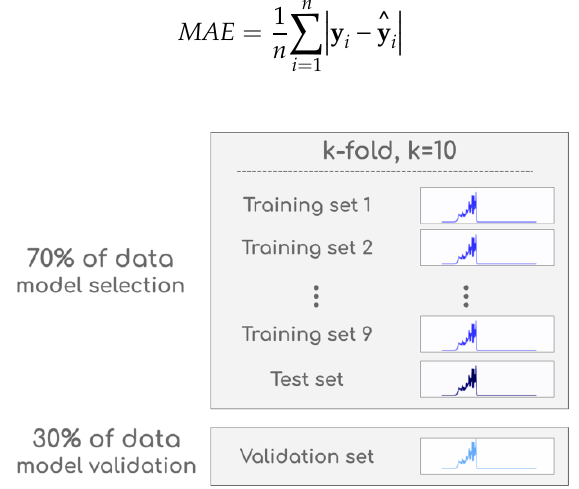
Figure 3. Cross-validation division of data for system training and results validation. Figure 2. Cross-validation division of data for system training and results validation.